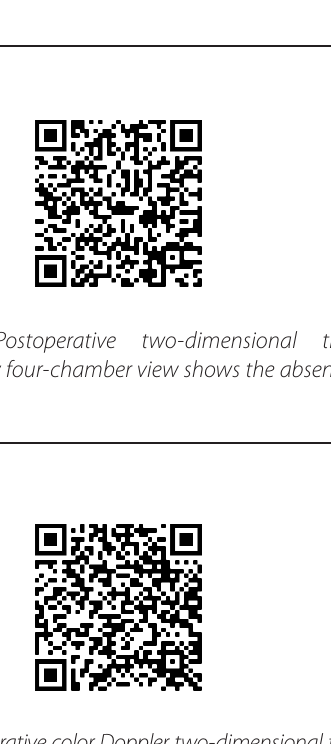
Video 3 - Two-dimensional transthoracic echocardiography shows right ventricular mass attached to the anterior leaflet of the tricuspid valve.